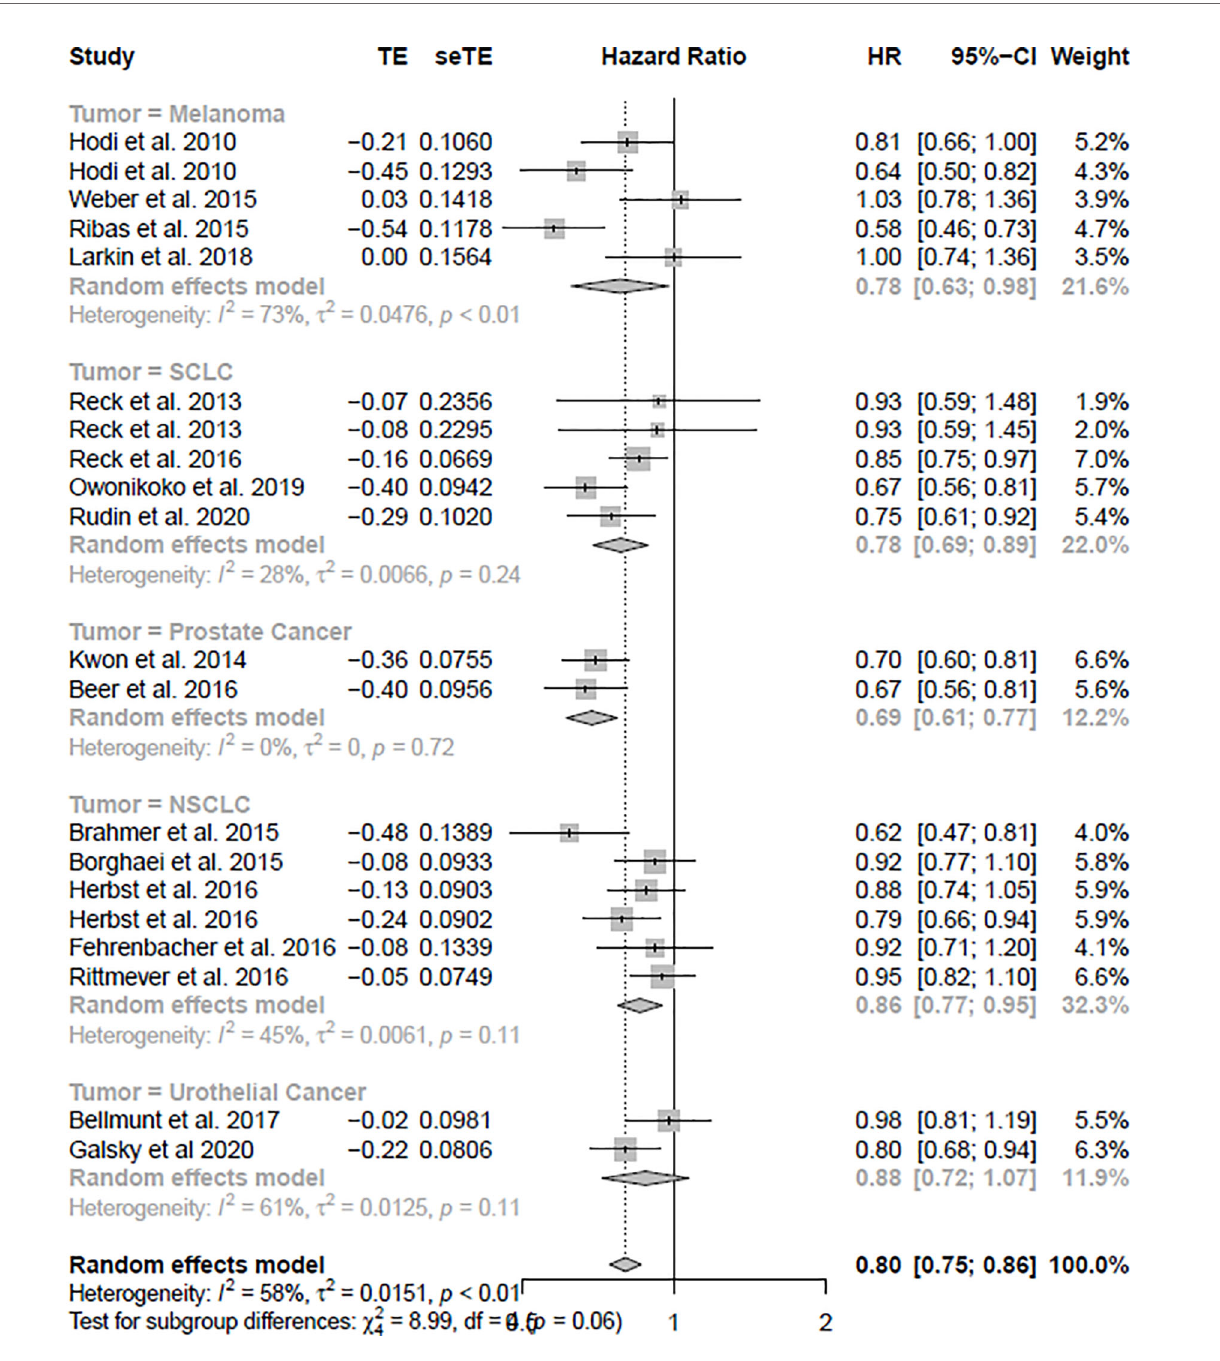
FIGURE 4 | The forest plot of PFS in the random effect